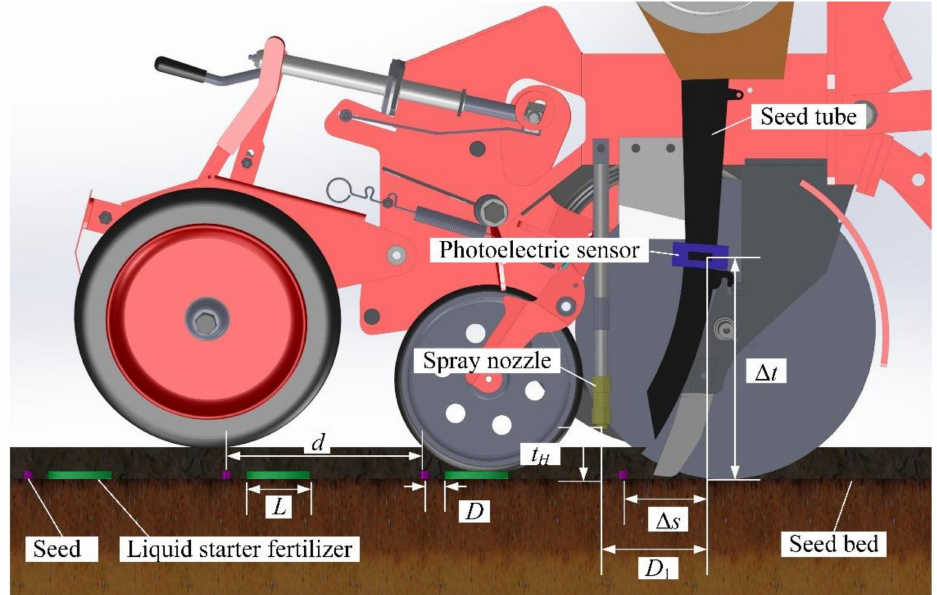
Figure 1. Method of applying a liquid starter fertilizer in point